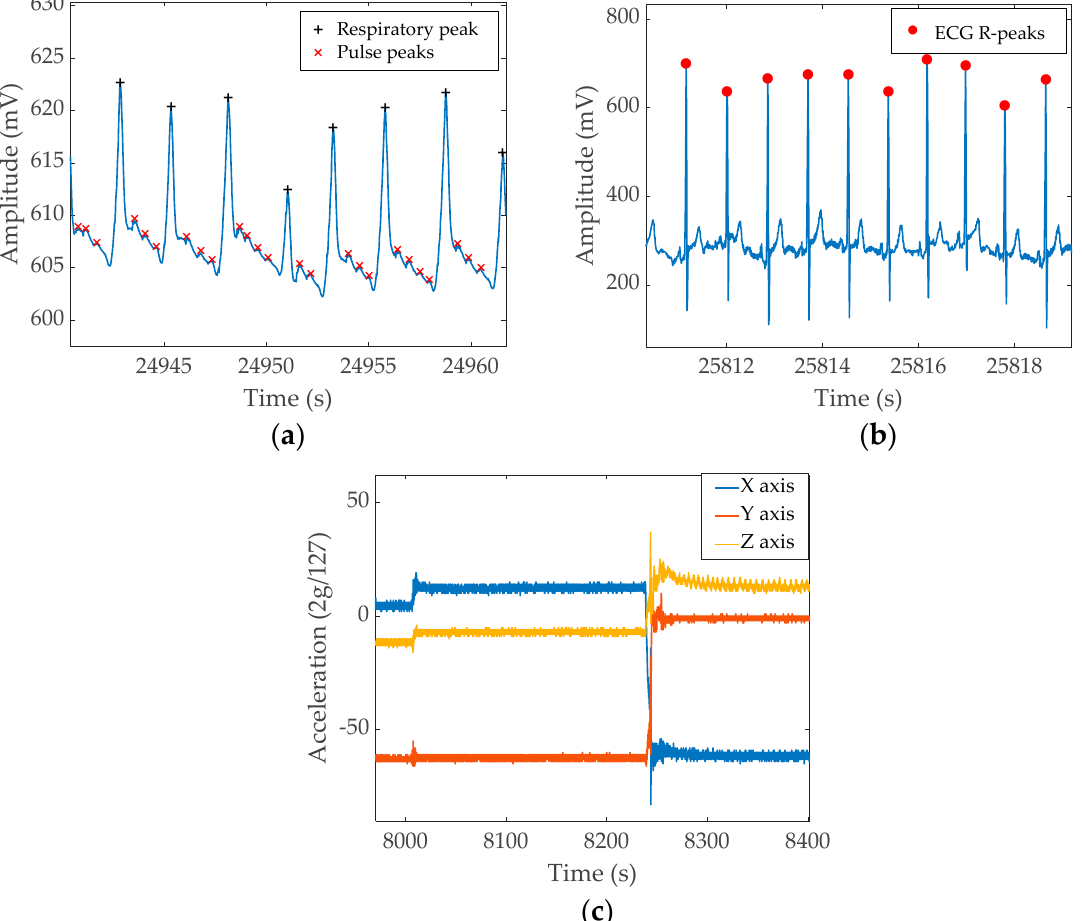
Figure 7. Example signal patterns from a full night recording. ( a ) ERB output, ( b ) ECG output, ( c ) X, Y, and Z axis output from the accelerometer. The figures show different sections extracted from the full night recordings.